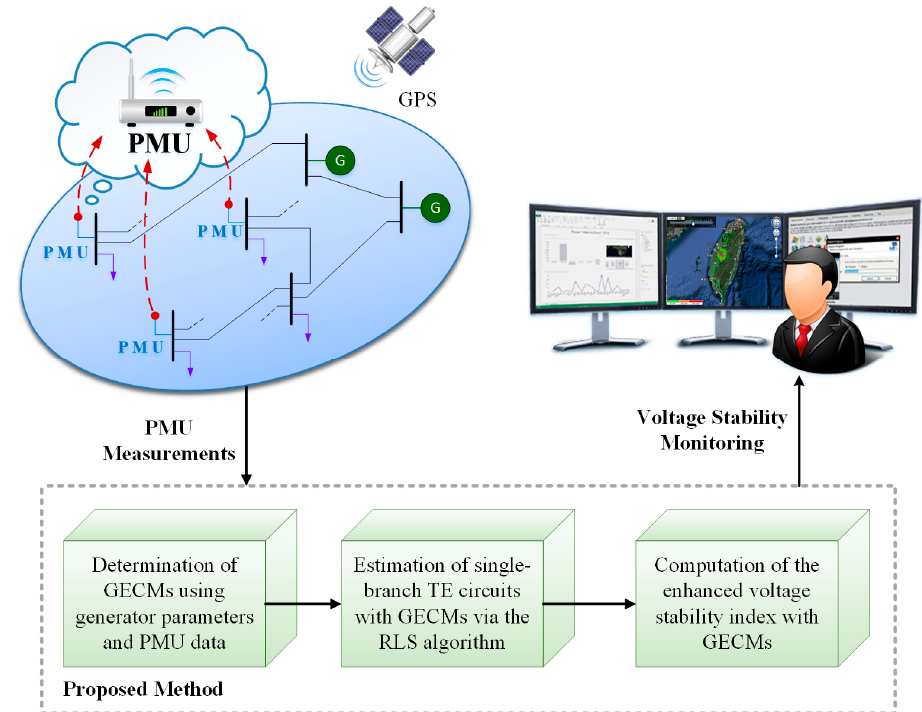
Figure 2. Overview of the proposed methodology.